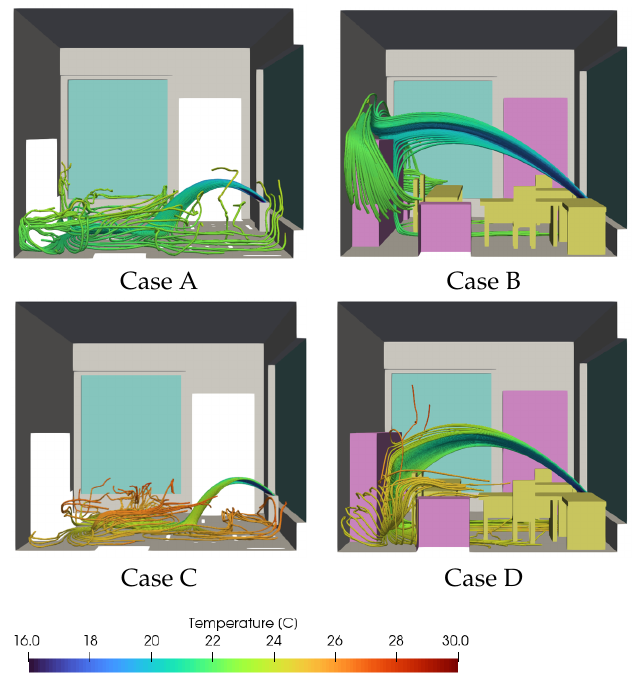
Figure 5. View from the entrance of the streamlines obtained for summer cooling with low input air velocity and no solar load (Case A), high input air velocity and no solar load (Case B), low input air velocity and solar load (Case C), high input air velocity and solar load (Case